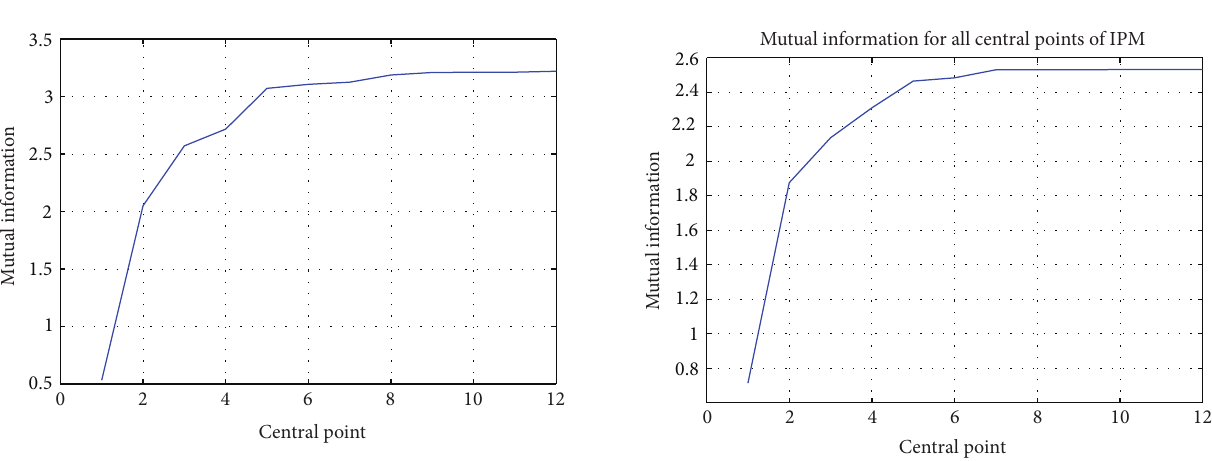
Figure 14: Mutual information for all central